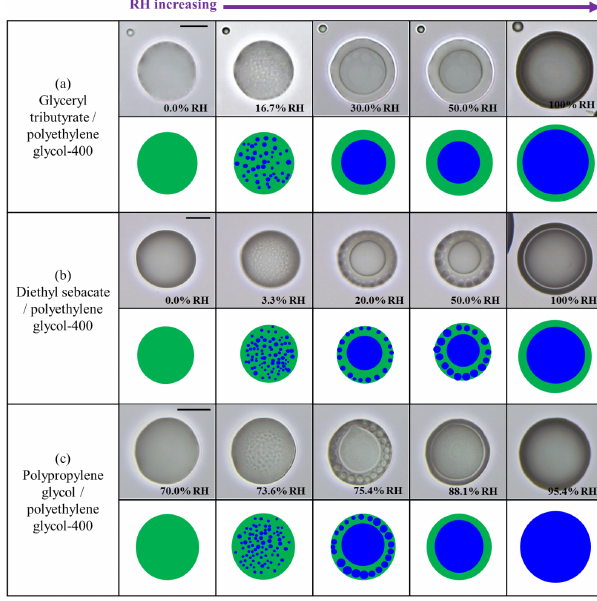
Figure 4. Optical images for particles consisting of two organic species for increasing RH: (a) glyceryl tributyrate/polyethylene glycol-400, (b) diethyl sebacate/ polyethylene glycol-400, and (c) poly(propylene glycol)/polyethylglycol-400. The particles are the same as shown in Fig. 3 but for increasing RH. Illustrations are presented below the images for clarity. Green: organic-rich phase. Blue: water-rich phase. The scale bar is 20µm.